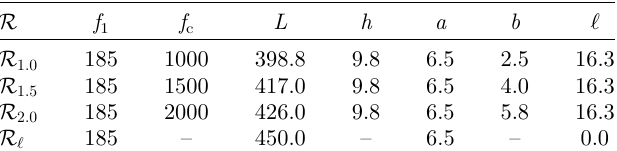
Table 1. Geometrical dimensions of three resonators with the same fi rst impedance peak f 1 and different cutoff frequencies f c